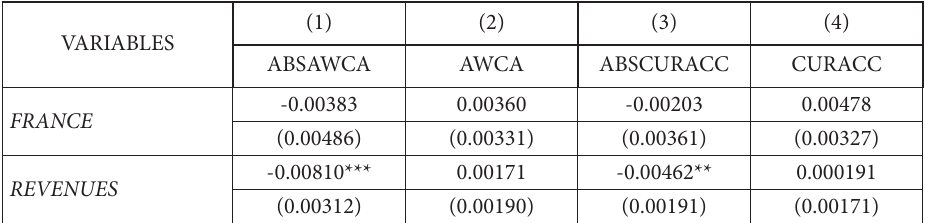
Table 4. The relationship between joint audits and discretionary accruals. Results of the estimations conducted with the French-civil-law subsample